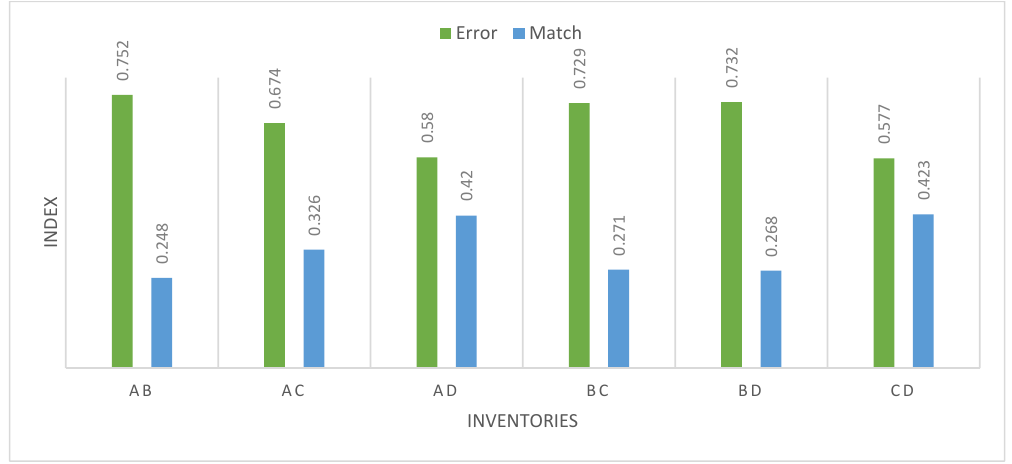
Figure 6. Pairwise comparison of inventories mapped by different interpreters.